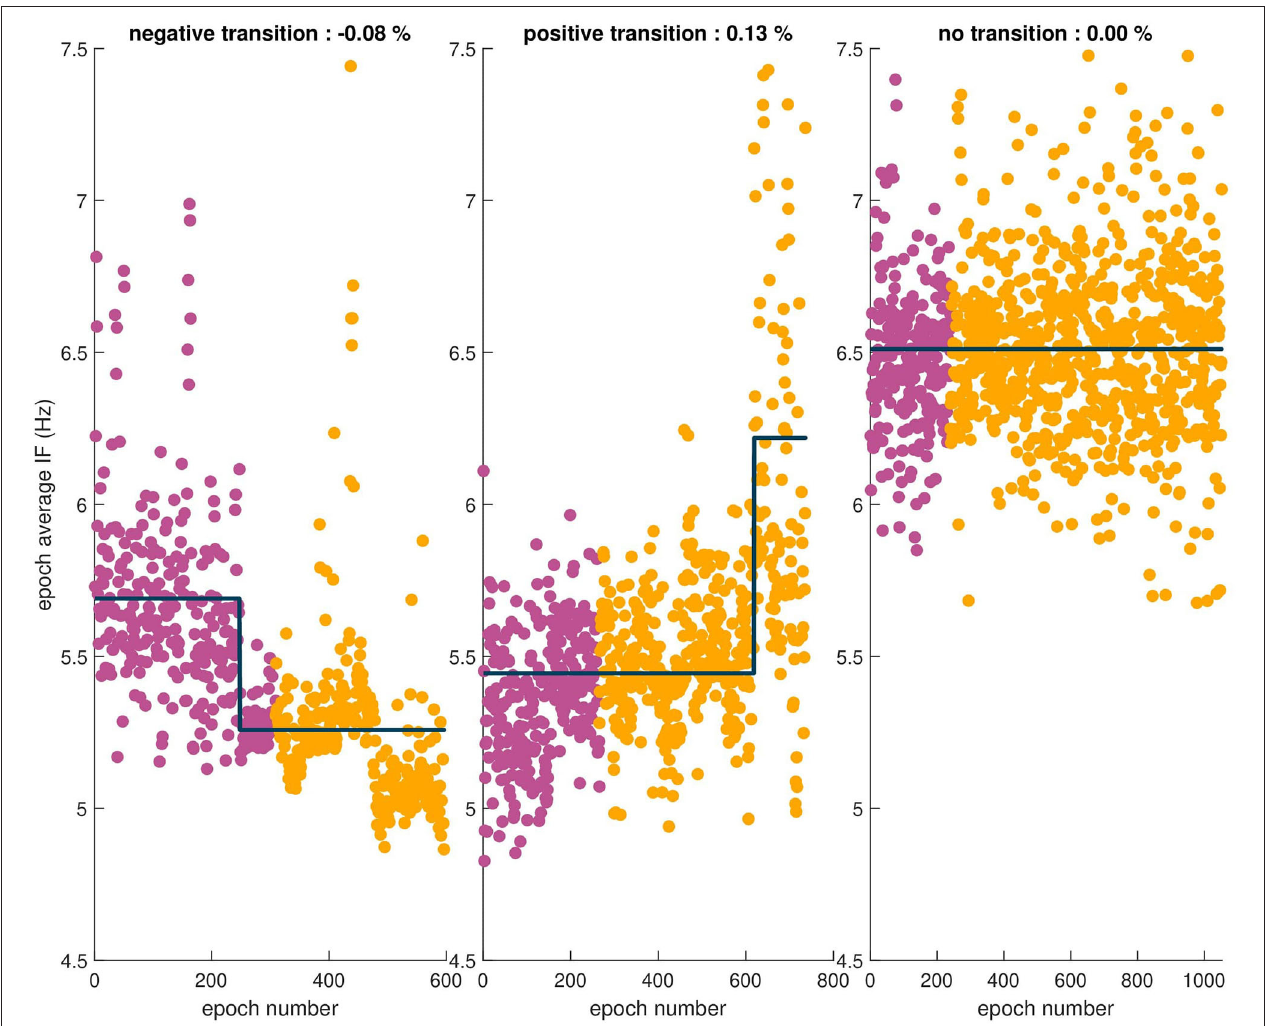
FIGURE 5 | Sequences of epoch average IF values for three patients. The observed relative percent change is indicated in the title of each example. From left to right, a negative transition in the mean, a positive transition in the mean, and finally no transition observed in the mean of the